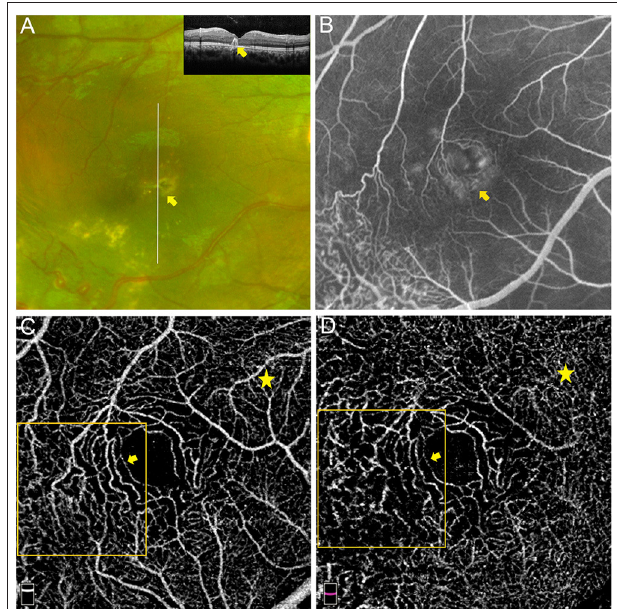
FIGURE 3 | Macular capillary abnormalities in eye with macular exudation. A 8 years old boy with Coats’ disease presented as intraretinal exudation in the macular region. Yellow exudates in the macular region on widefield fundus photography and hyperreflective exudates involving the neuro-retina on OCT imaging [ (A) yellow arrows]. Hyperfluorescent leakage and vague telangiectasia in the macular area on FA [ (B) captured at 14.3s]. Telangiectasia and capillary tortuosity in the SCP [ (C) 3 × 3mm] and DCP [ (D) 3 × 3mm] were detected via OCTA (orange boxes and yellow arrows), which presented as more dilated and tortuous microvascular structures in contrast to the capillaries in the nasal region of the macula (yellow stars).